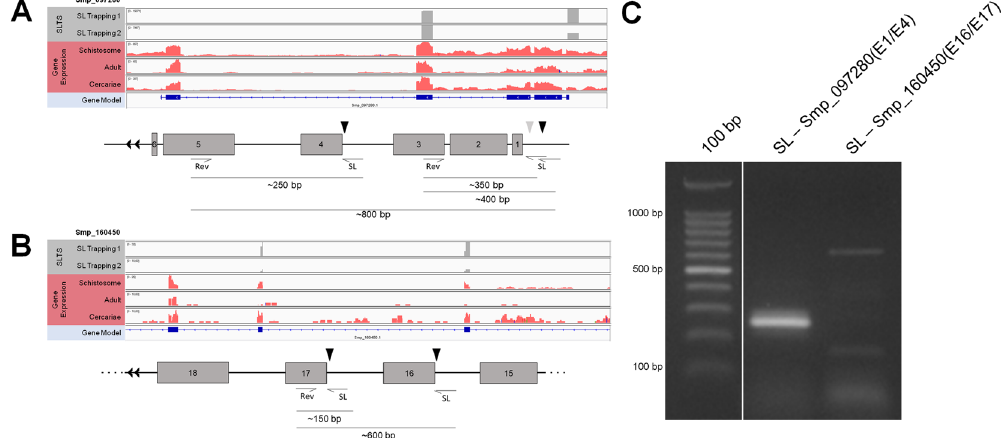
Figure 7. RT-PCR validation of internal trans-spliced genes. Genome browser and schematic view of the exon- intron structure of the genes Smp_062830 ( A ) and Smp_196960 ( B ) undergoing SLTS, with the superimposed coverage for the SL Trapping 1 and 2 datasets (top tracks) and the RNA-Seq dataset (middle tracks). Black arrows show the SL insertion sites and gray arrows show secondary SL insertion sites. The expected fragment sizes are described in the schematic representations. ( C ) RT-PCR validation of internal trans-splicing in the case studies using SL as forward primer and an exon-specific reverse primer. Full-length gels are presented in Supplementary Figure S5 D.